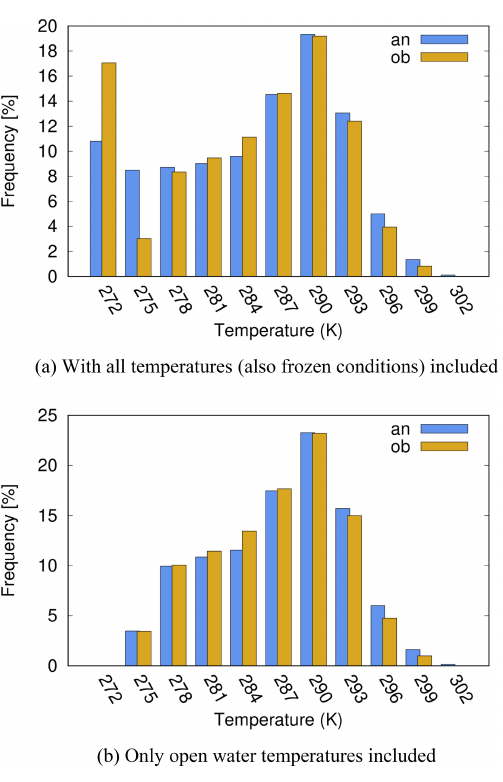
Figure 3. Frequency of observed (ob, yellow) and forecast (fc, blue) LSWTs over all 27 SYKE lakes 2012–2018; x axis: LSWT, unit is kelvin, classified in 3-degree intervals from 270.1 to 303.1K; y axis: frequency, unit is percent.